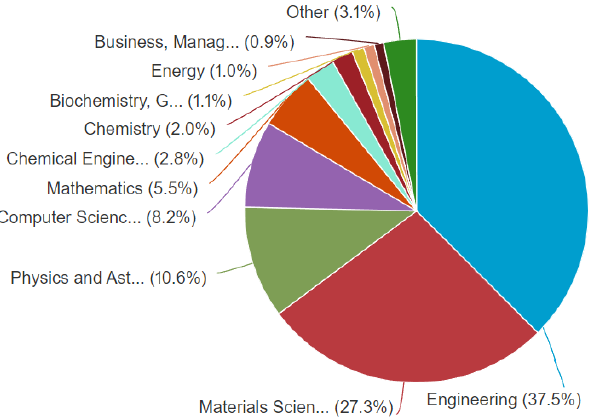
Figure 9. Literature search distribution on the classification of publications by subjects on ‘additive manufacturing on lattice structures’, (Scopus database on 20 June 2022).